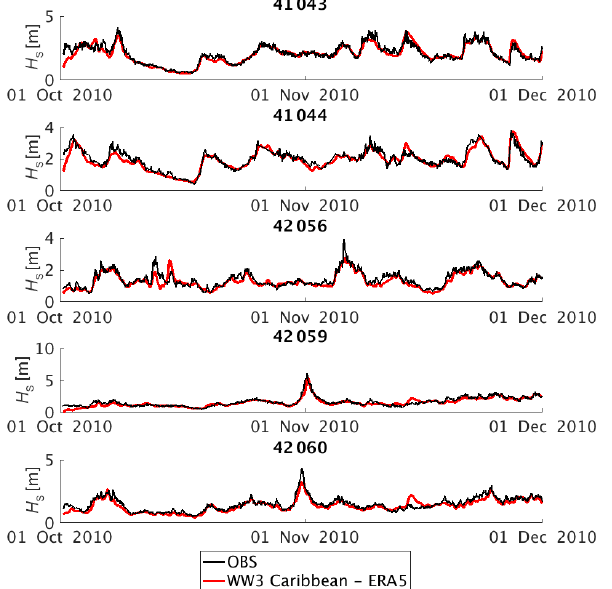
Figure 4. Comparison between the significant wave heights ob- served by five buoys from the NOAA National Data Buoy Cen- ter and modelled by the WW3 Caribbean model forced by ERA5 reanalysis winds. Validation is for October and November 2010, covering the passage of Hurricane Tomas (29 October–14 Novem- ber 2010).